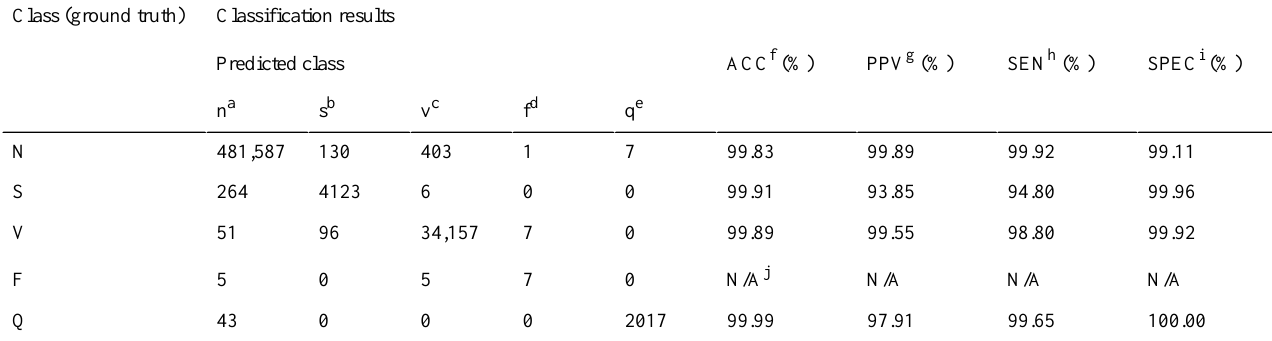
Table 4. A confusion matrix of the lightweight model for the test set. Classification resultsClass (ground truth)